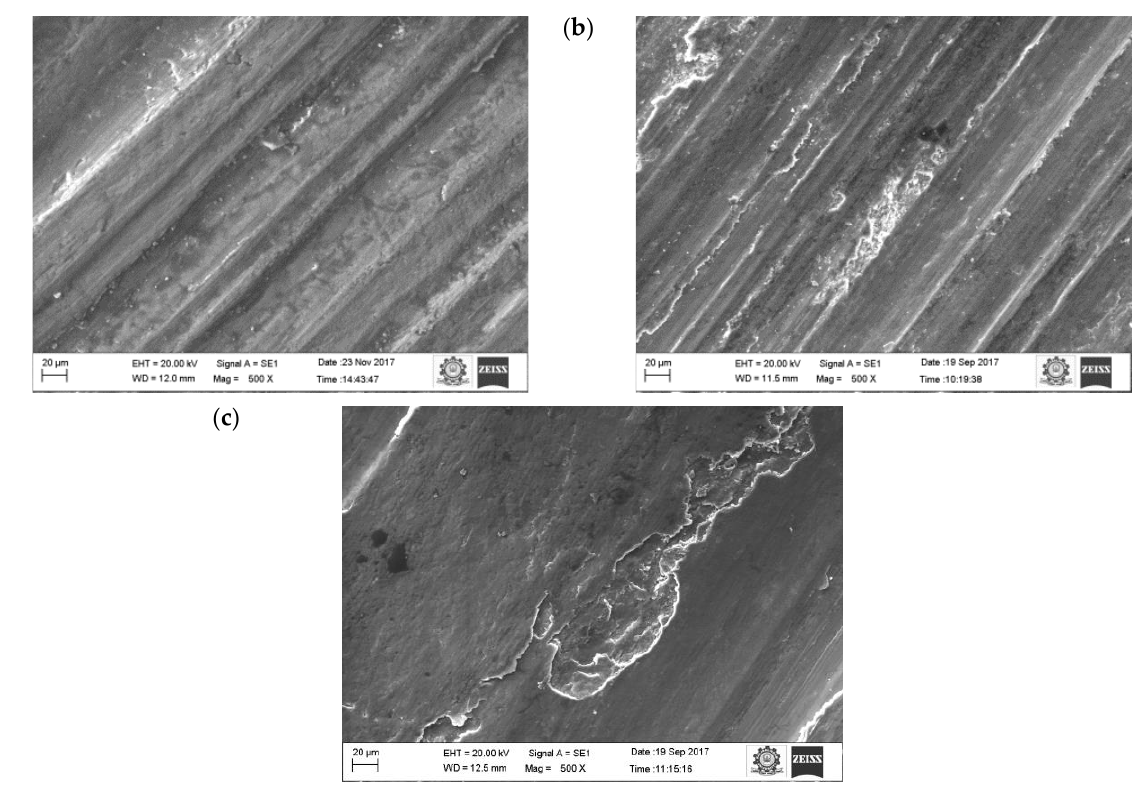
Figure 10. Worn surface morphology (SEM images) of the 5 wt.% composite: ( a ) 0.75 m/s ( b ) 1.5 m/s ( c ) 2.25 m/s.